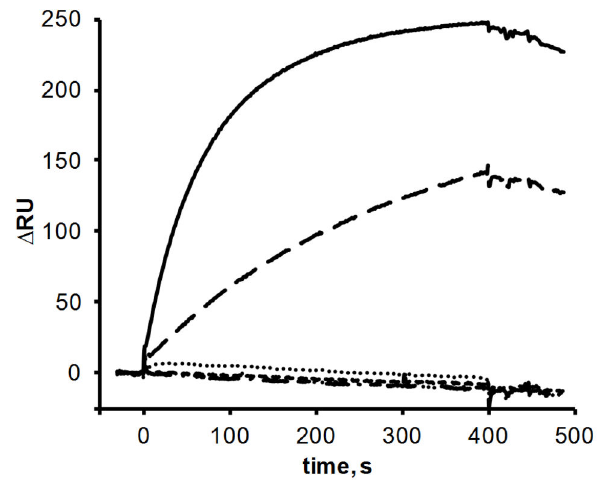
Figure 2. SPR analysis of the interaction of sensor-chip bound NAGK with P or Venus-tagged P variants. His- II II tagged NAGK protein was immobilized on the surface of flow cell (FC) 2 of a Ni-NTA coated sensor chip; FC 1 served as a control for unspecific binding. P -wt (solid line), P -ST ‑ V (long- II II dashed line), P -S49G ‑ ST (dotted line), P -S49G ‑ ST ‑ V (dashed II II line), P -E85A-ST ‑ V (dot-dot-dashed line) and P -S49G-E85A- II II ST ‑ V (dot-dashed line) were used as analyte. The response difference (∆RU) between FC2 and FC1 during injection and one minute of dissociation is shown.